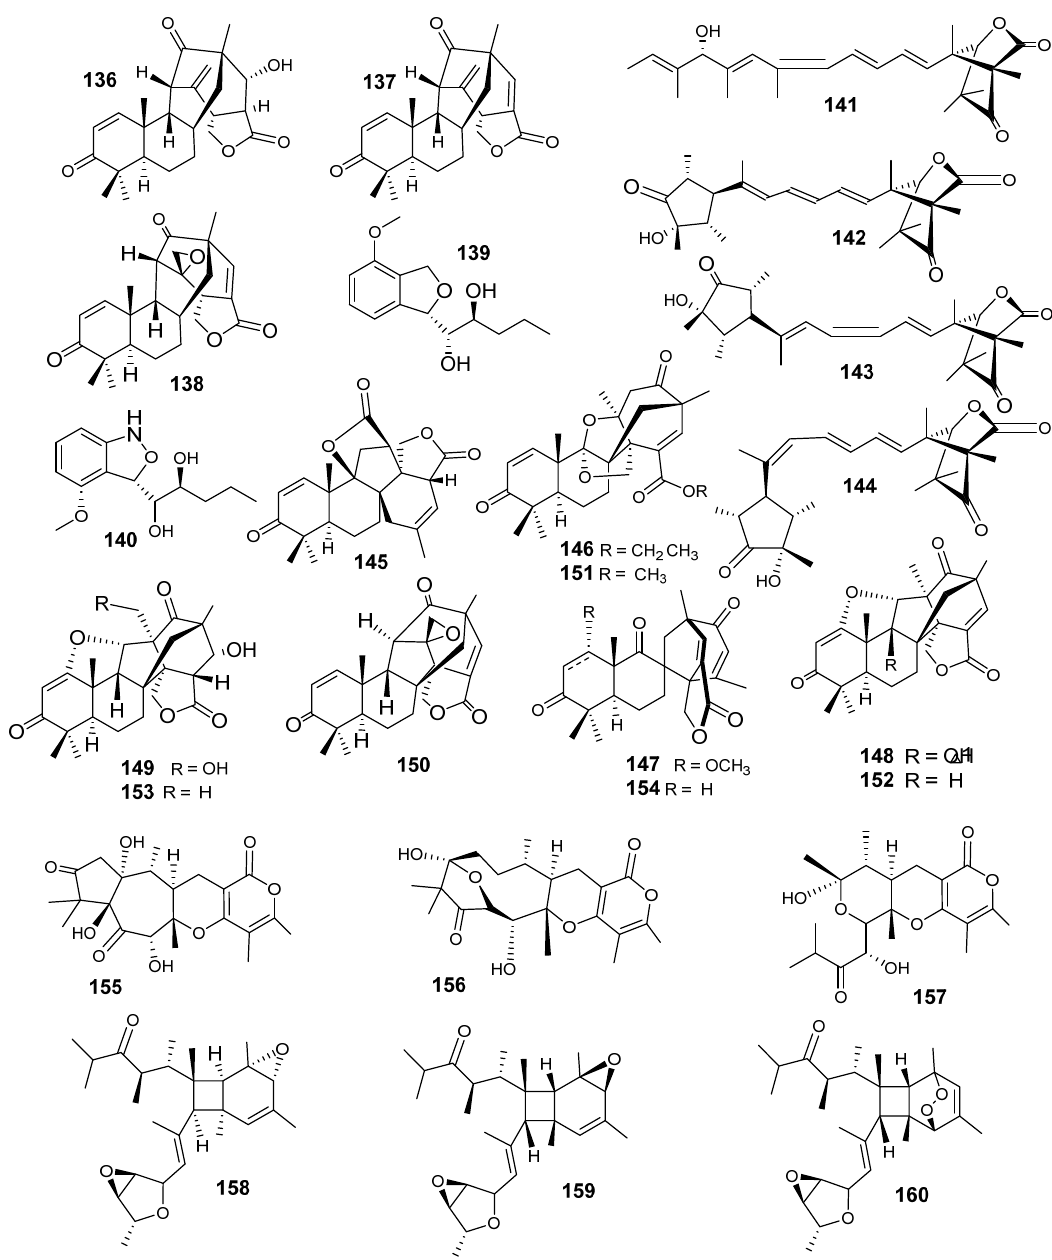
Figure 10. Structures of compounds 136–160.